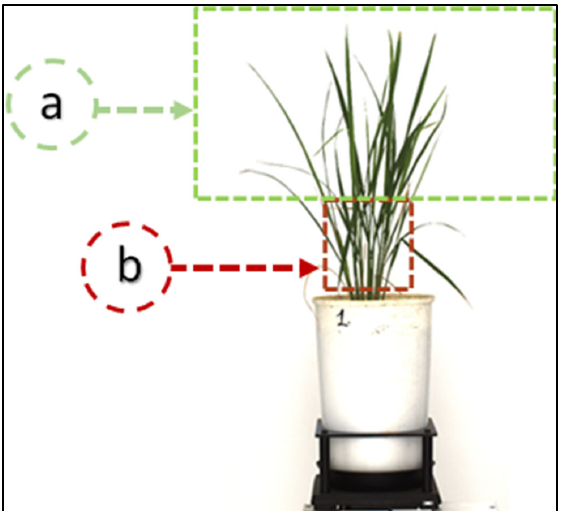
Figure 4. Rice plant at the vegetative stage depicting leaf distribution in a rice plant: ( a ) leaves are sparsely distributed and less overlapping at the upper part of the plants, whereas, ( b ) just above the ground, near the sheath area, the leaves are thin, generally hidden, and